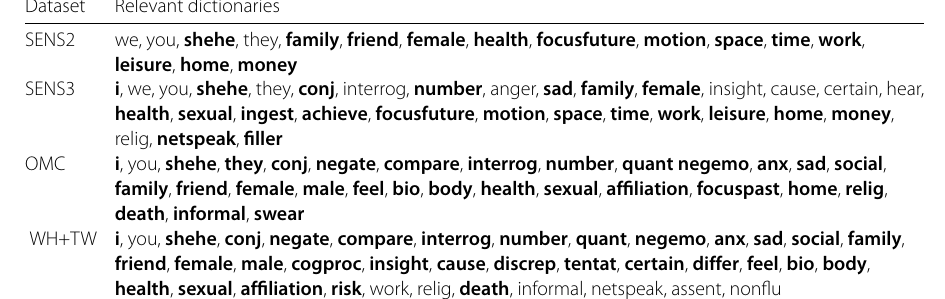
Table 10 Psychological categories of LIWC [45]